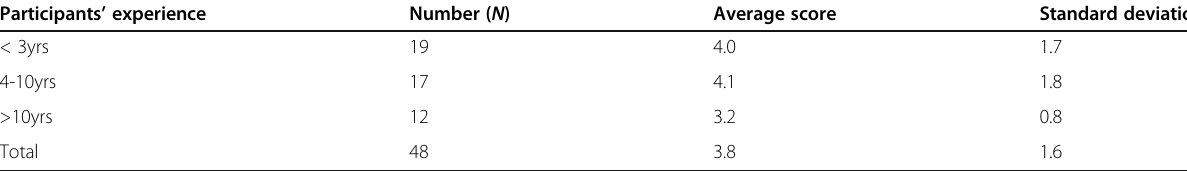
Table 1 Participants ’ average knowledge score according to years of experience Participants ’ experience